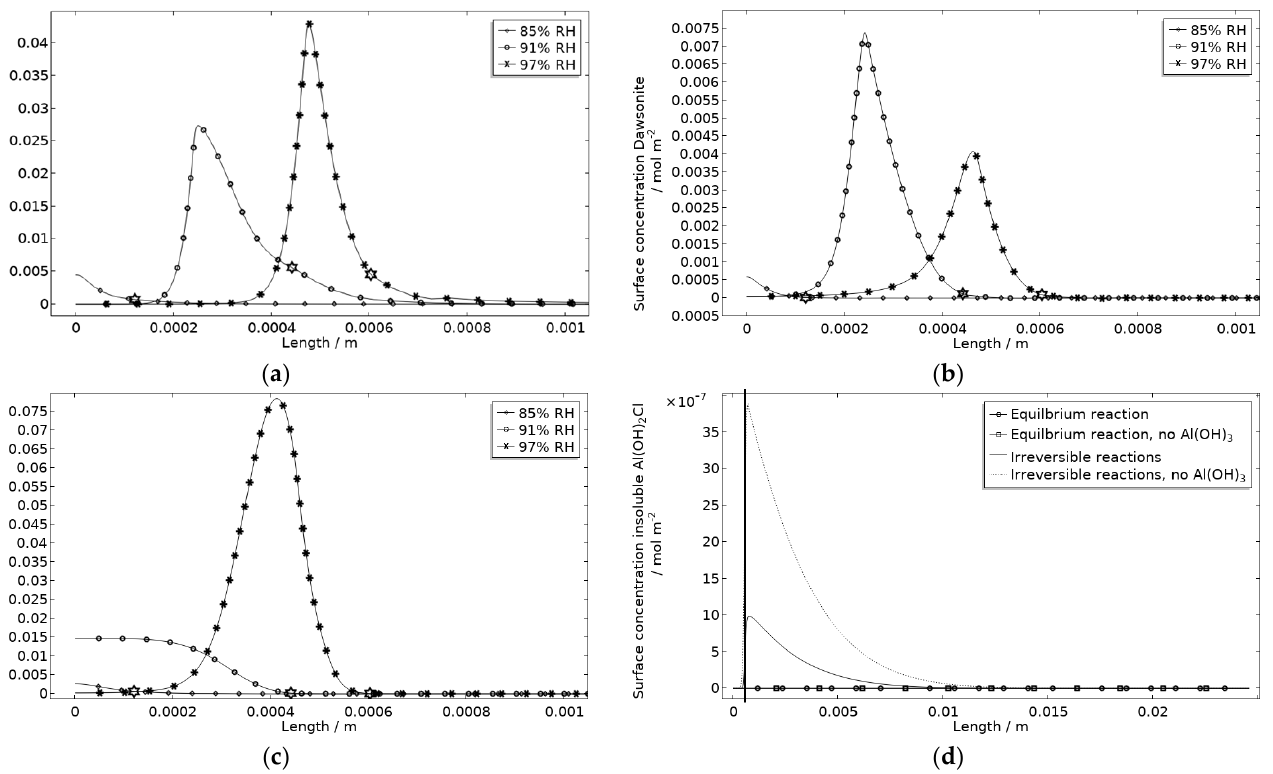
Figure 18. Corrosion product surface concentration at and near the stainless steel of the calibration cell after 5 h exposure with 86 μg NaCl/cm 2 load at 21 °C and indicated RH. ( a ) Insoluble Al(OH) 3 . ( b ) Dawsonite with formation of insoluble Al(OH) 3 . ( c ) Dawsonite without formation of insoluble Al(OH) 3 . ( d ) Insoluble Al(OH) 2 Cl with and without formation of insoluble Al(OH) 3 . Star marker in (a)-(c) highlights center of corroding surface, leftmost 85% RH, middle 91% RH, and rightmost 97% RH. Vertical thick line in (d) displays location of corroding surface.